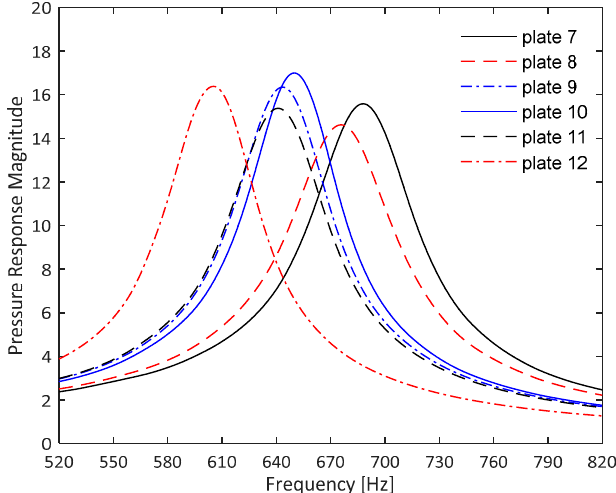
Figure 16. Experimental pressure response functions for plate 7 to plate 12.